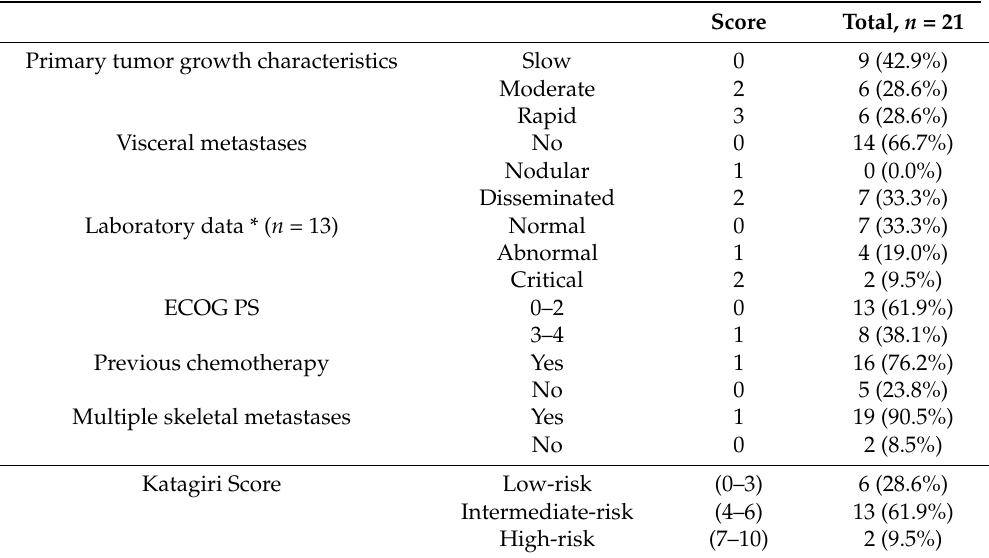
Table 4. Katagiri score evaluation of survival [20,21].